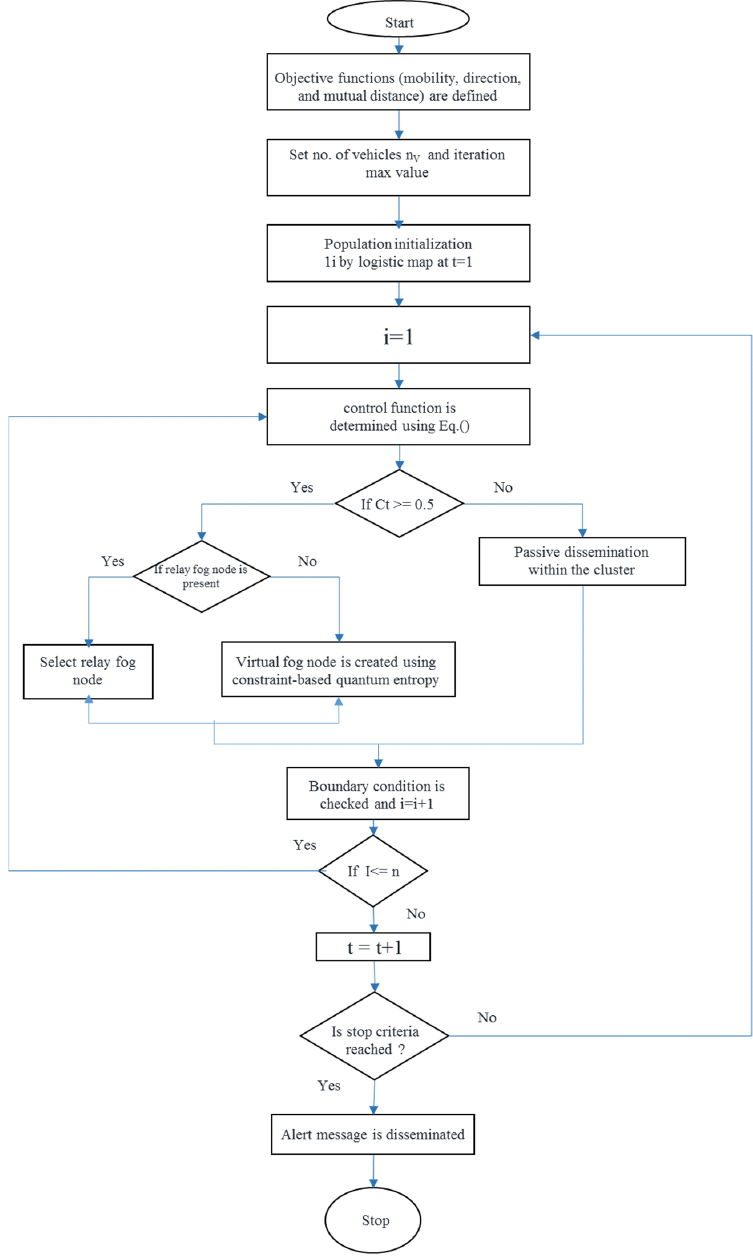
Figure 4. Overall Flow of Alert Message Dissemination.